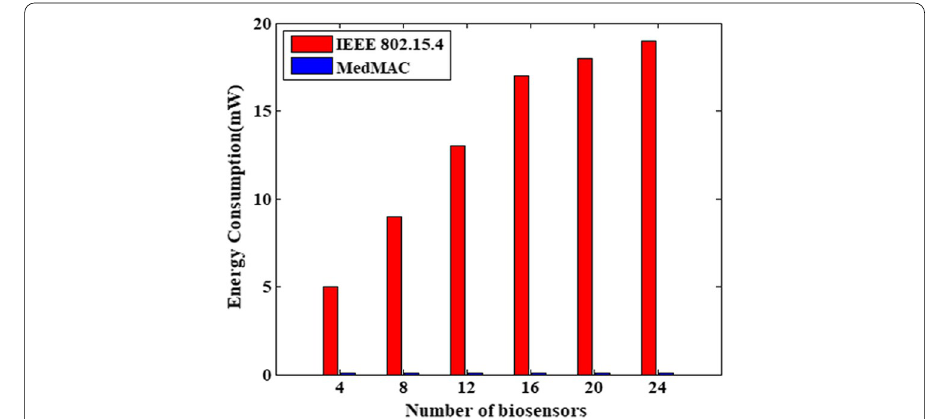
Fig. 8 Average energy consumption versus number of